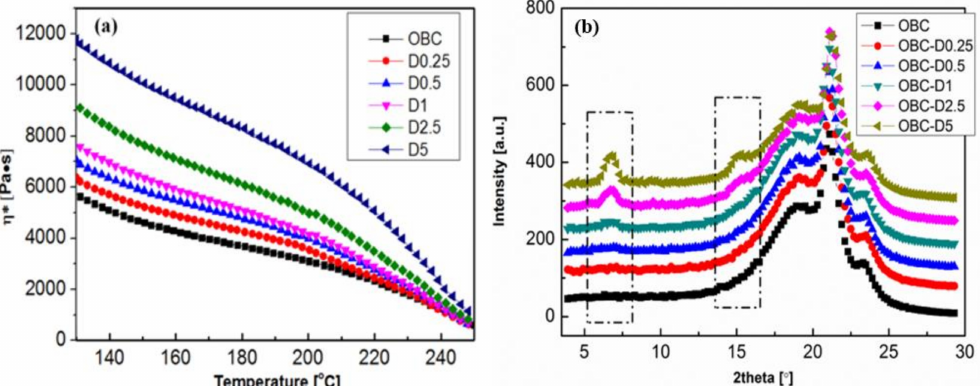
Figure 2. ( a ) Temperature dependence of complex viscosity as a function of DMDBS concentration during cooling at 2 ◦ C/min and after annealing at 260 ◦ C for 10 min; ( b ) 1d-wide-angle X-ray diffraction (WAXD) diffraction intensity as a function of 2 θ for OBC/DMDBS